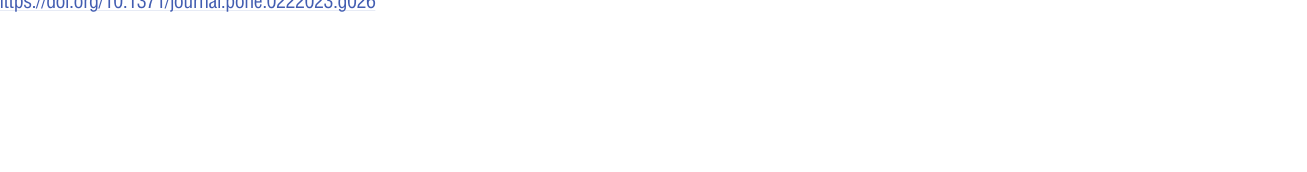
PLOS ONE | https://doi.org/10.1371/journal.pone.0222023 September 11, 2019 32 /